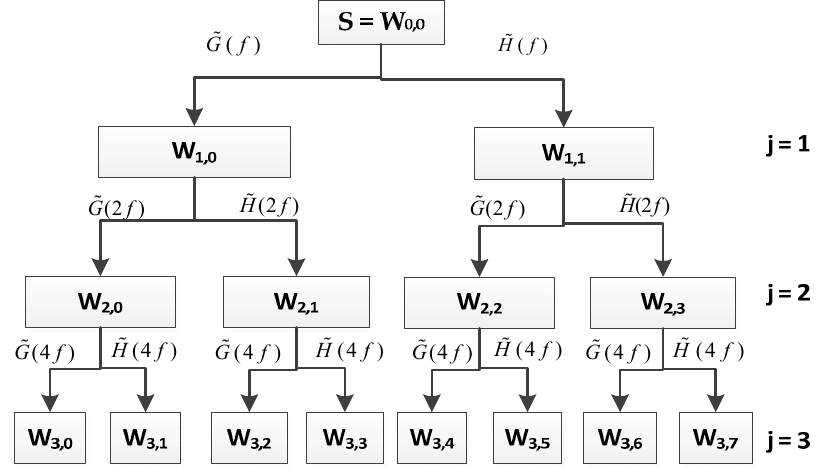
Figure 6. Full wavelet packet tree down to level